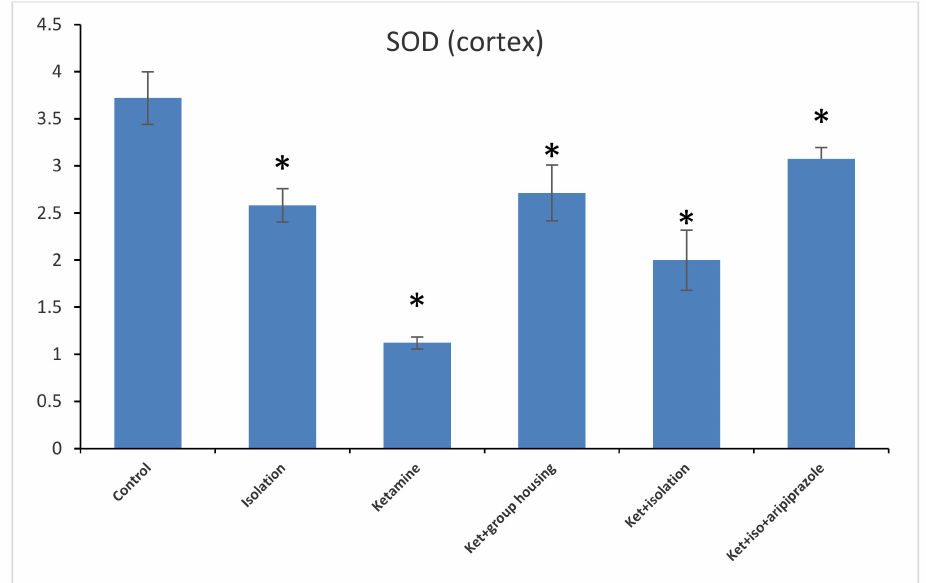
Figure 10. The effects of social isolation, ketamine, combined ketamine and social isolation, and combined ketamine, social isolation, and aripiprazole treatment on SOD-specific activity in cortex brain samples (measured in U/mg of protein). The values are mean ± SD ( n = 7 per group). * Significantly different when compared to control group ( p <